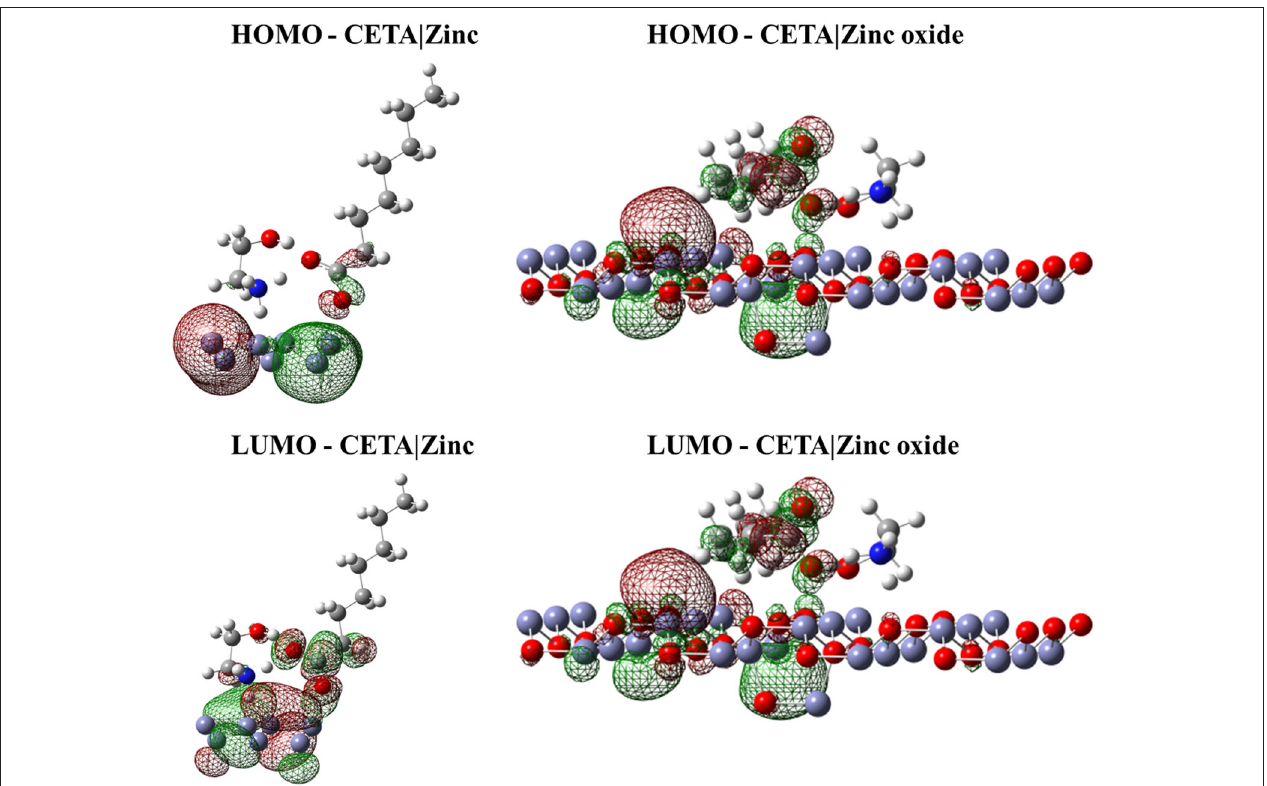
FIGURE 4 | Isodensity surfaces (density value = 0.0001 A − 3 ) of HOMO and LUMO orbitals of CETA molecule with the zinc and zinc oxide surfaces. The red color represents the negative part of the wave function and the green color corresponds to the positive